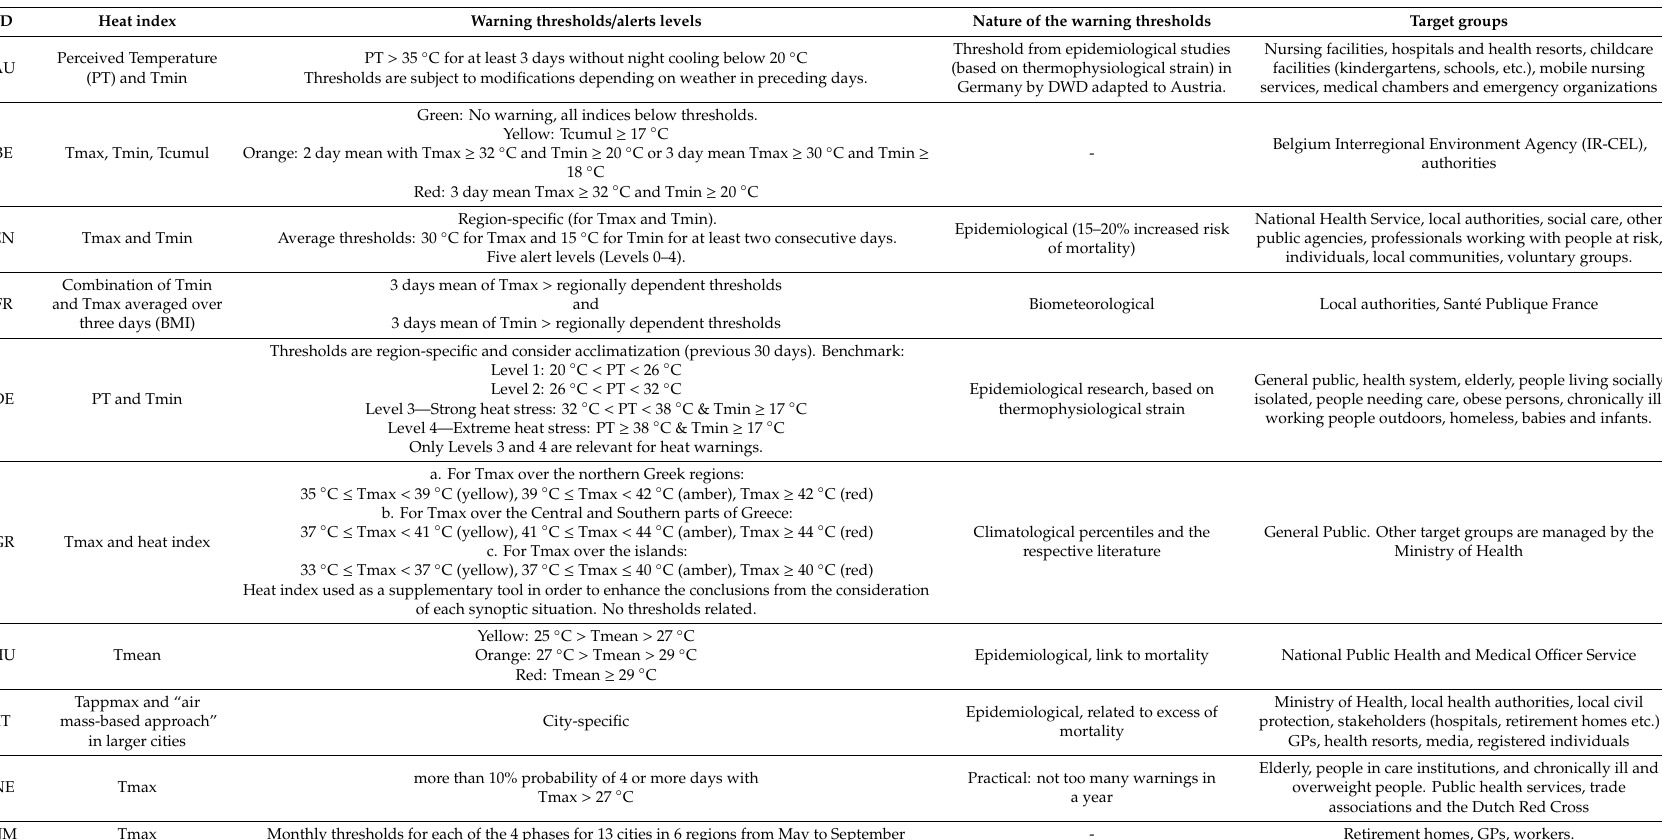
Table 2. Characteristics of the warning system.